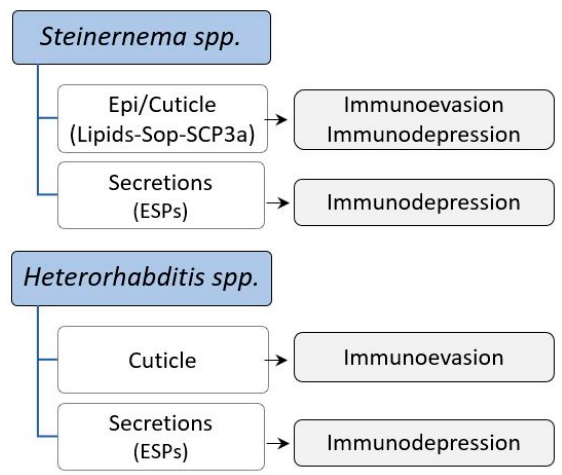
Figure 9. A schematic of the effects of EPN body surfaces and secretions on the immune responses of target insects.